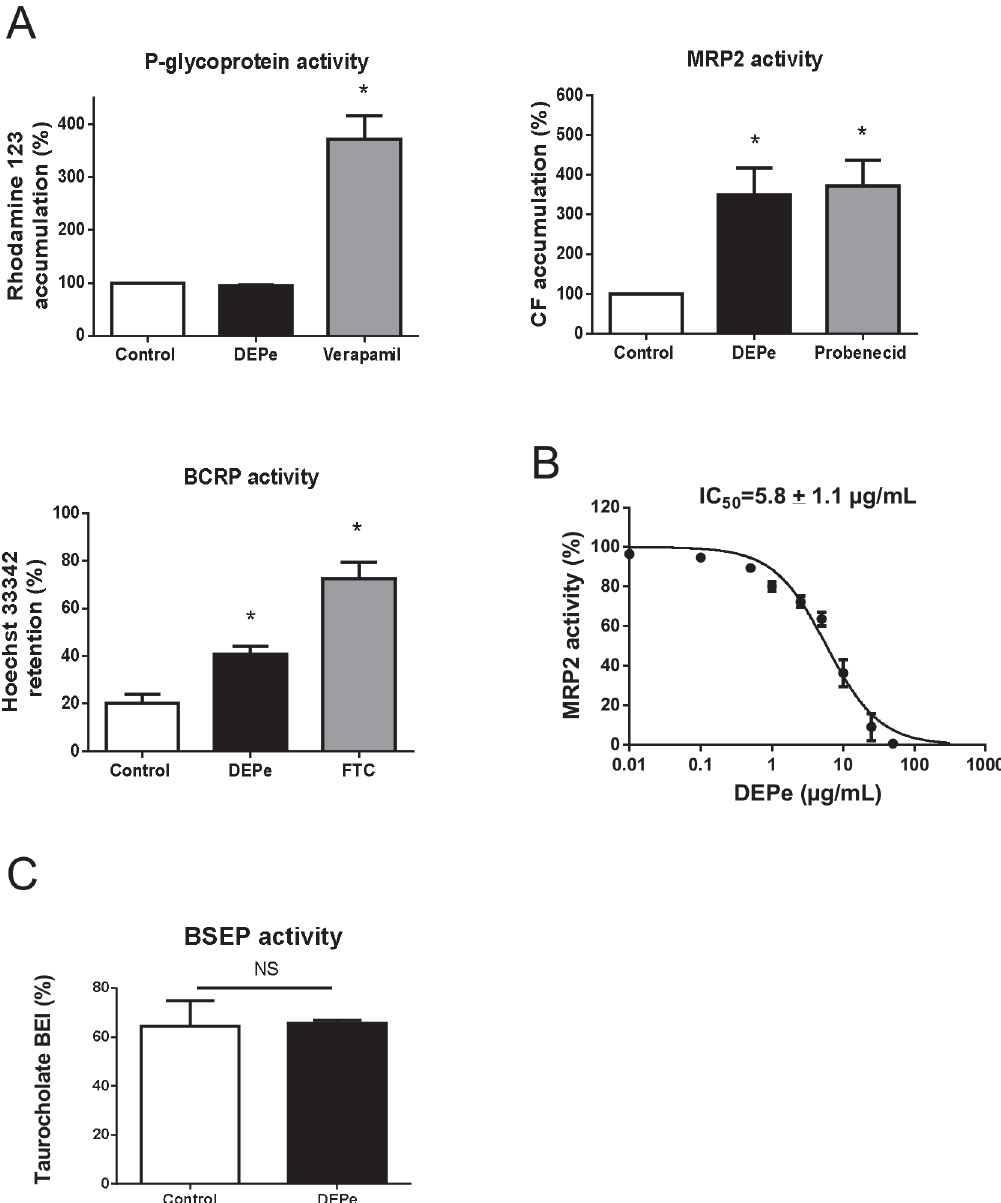
Fig 3. Effects of DEPe on P-glycoprotein, BCRP, MRP2 and BSEP transport activity. (A) P-glycoprotein, BCRP and MRP2 activities were determined through measurement of rhodamine 123 accumulation, Hoechst 33342 retention and CF accumulation in transporter-expressing cell lines in the absence or presence of 25 μ g/mL DEPe as reported in the Material and Methods. Reference inhibition of transporter activity was obtained in parallel through addition of 50 μ M verapamil (P-glycoprotein inhibition), 10 μ M fumitremorgin C (FTC) (BCRP inhibition) or 10 mM probenecid (OATP inhibition). Data are expressed as % of dye accumulation (P-glycoprotein and MRP2 activities) or dye retention (BCRP activity) in control untreated cells; they are the means ± SEM of at least three independent experiments. * , p < 0.05 when compared to control cells (ANOVA followed by a Dunnett ’ s post-hoc test). (B) CF accumulation was measured in HuH-7 cells in the absence or presence of various concentrations of DEPe (from 0.1 to 50 μ g/mL) or of the reference OATP inhibitor probenecid. Data are expressed as % of MRP2 activity calculated as described in Materials and Methods and are the means ± SEM of four independent assays. DEPe IC 50 value is indicated at the top of the graph. (C) BEI for taurocholate, reflecting BSEP activity, was determined in primary human hepatocytes in the absence or presence of 25 μ g/mL DEPe, as reported in Materials and Methods. Data are the means ± SEM of three independent experiments. NS, not significant (Student ’ s